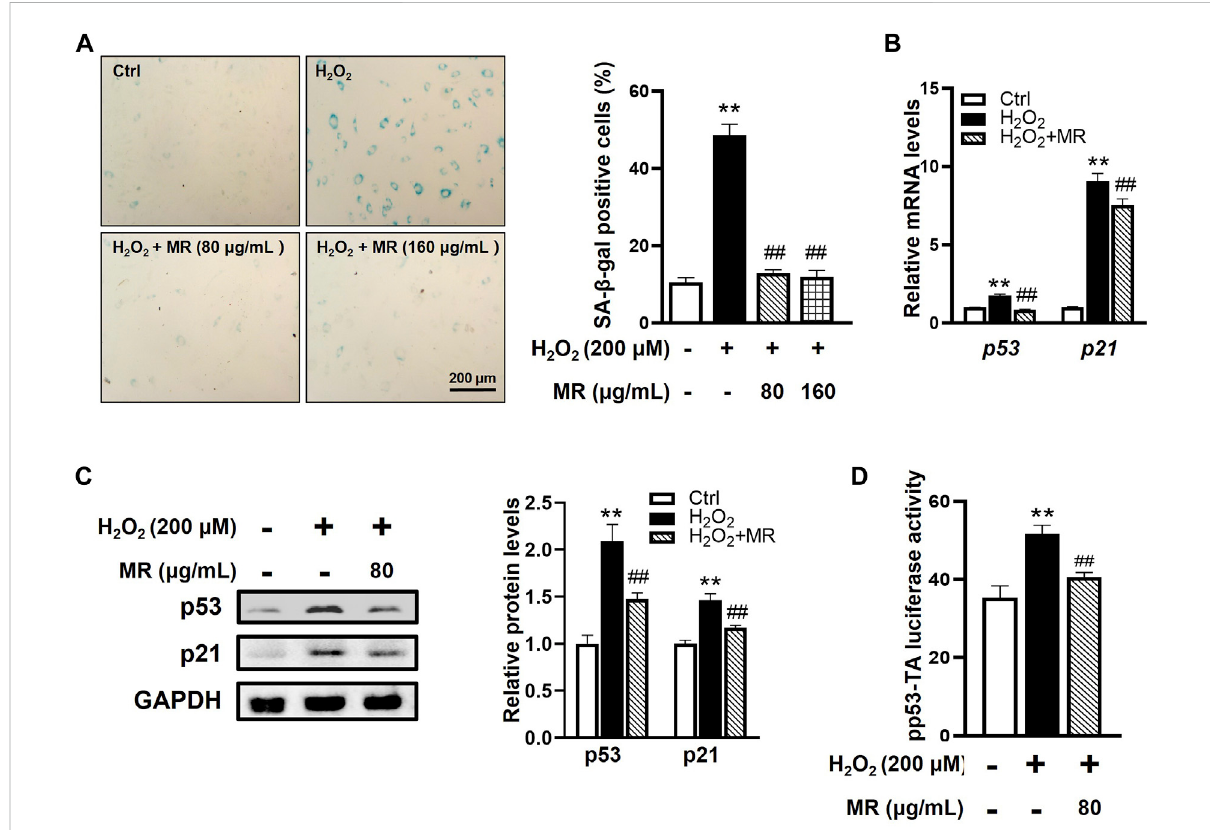
FIGURE 3 MRinhibitsH 2 O 2 -inducedcellsenescenceofrNPcells.rNPcellswerepretreatedwithindicatedconcentrations(200and400 μ M)ofMRfor2 h and then treated with 200 μ M H 2 O 2 for another 2 h. (A) SA- β -gal staining results showed that MR treatment resulted in a reduction of SA- β -gal- positive cells in rNP cells induced by H 2 O 2 . (B) qPCR assay results showed that the expression of p53 and p21 mRNA induced by H 2 O 2 was signi fi cantly decreasedinMR-treatedrNPcells. (C) WesternblotresultsshowedthatMRsupplementationreversedtheenhancedexpressionof p53andp21proteinsinH 2 O 2 -inducedrNPcells. (D)